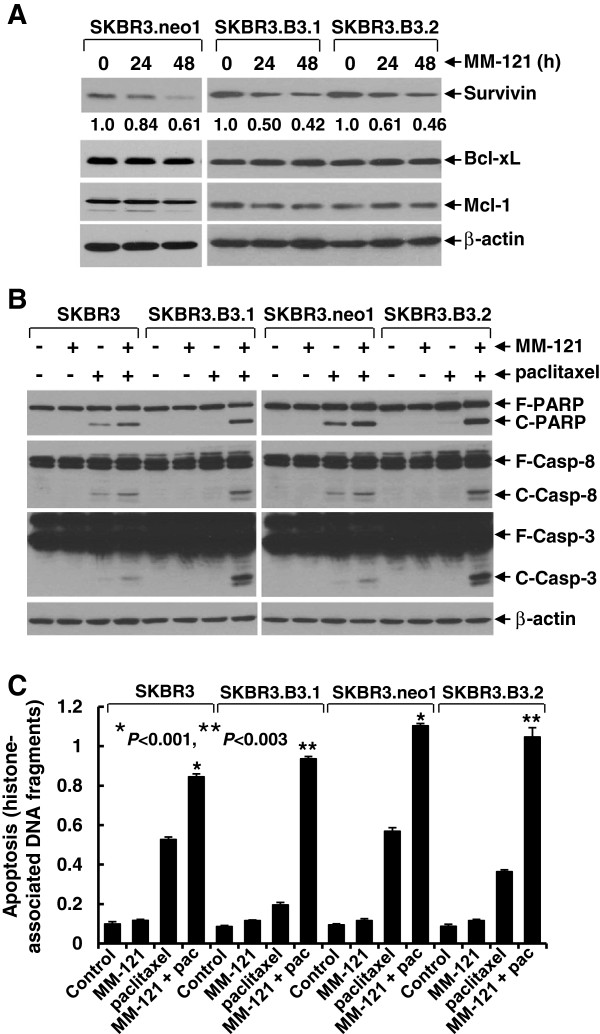
MM-121 specifically downregulates Survivin and significantly enhances paclitaxel-induced apoptosis in paclitaxel-sensitive and -resistant breast cancer cells. (A) SKBR3.neo1, SKBR3.B3.1, or SKBR3.B3.2 cells were untreated, or treated with MM-121 (10 μg/ml) for 24 or 48 h. Cells were collected and subjected to western blot analyses of Survivin, Bcl-xL, Mcl-1, or β-actin. The densitometry analyses of Survivin signals are shown underneath, and the arbitrary numbers indicate the intensities of each cell line relative to controls, defined as 1.0. (B and C) SKBR3 and SKBR3.B3.1, or SKBR3.neo1 and SKBR3.B3.2 cells were untreated, or treated with either MM-121 (10 μg/ml) or paclitaxel (3 nmol/L) alone, or their combinations for 24 h. Cells were collected (samples of SKBR3 and SKBR3.B3.1 cells were run on one gel, and samples from SKBR3.neo1 and SKBR3.B3.2 cells were run on another) and subjected to western blot analyses of poly(ADP-ribose) polymerase (PARP: F-PARP, full-length PARP; C-PARP, cleaved PARP), caspase-8 (F-Casp-8, full-length caspase-8; C-Casp-8, cleaved caspase-8), caspase-3 (F-Casp-3, full-length caspase-3; C-Casp-3, cleaved caspase-3), or β-actin (B); or a specific apoptosis ELISA (C). Bars represent SD. *P <0.001 and **P <0.003 versus single-agent treatment.